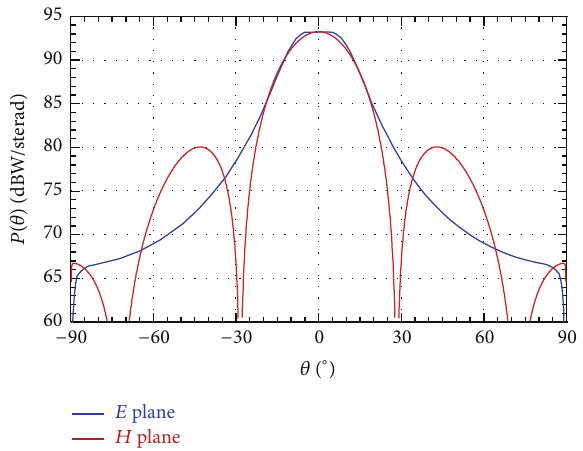
Figure 10: Radiation patterns in the 𝐸 and 𝐻 planes at 𝑓 = 1 GHz for a structure with 𝑏 = 𝜆 0 /300 and 𝐵 𝑓 = 47.75 excited by a linear array of 21 equiamplitude HMDs placed along the 𝑥 -axis with spacing 𝑑 = 𝜆 0 /10